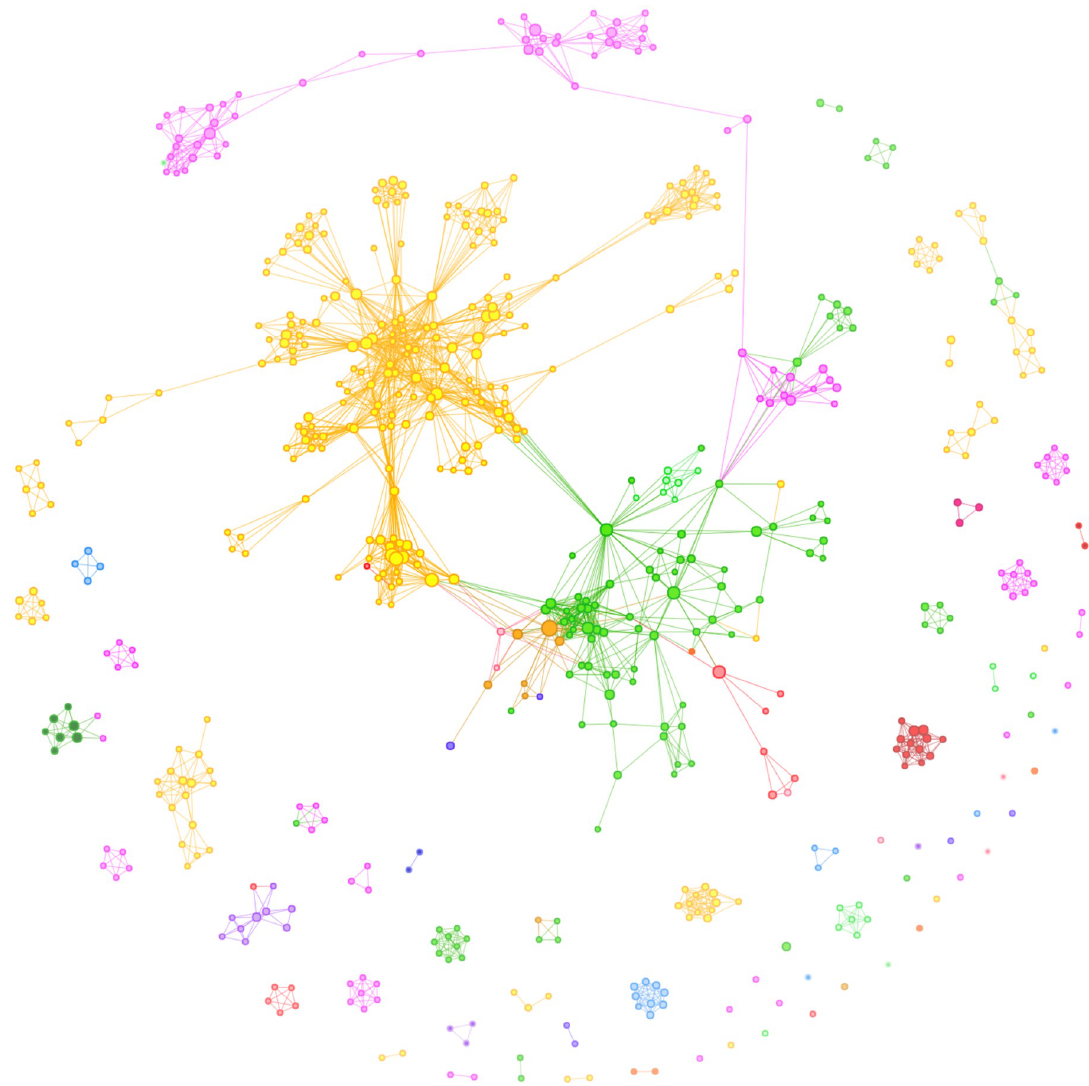
Fig 2. Visualisation of co-authorship network for DCM research. Colours show country. Author node size shows number of papers published. Authors shown as lone nodes do not have any collaborations with the other “prolific” selected